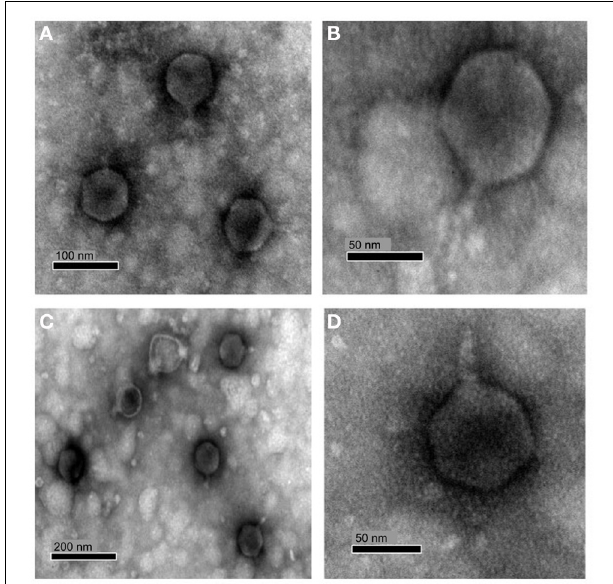
FIGURE 1 | TEM micrograph of RLP1 and RPP1 negatively stained with uranyl acetate. RLP1— (A,B) and RPP1— (C,D) . Based on their morphology phages were classified into the Podoviridae family. Magnification: (A) × 120,000, (B) × 300,000 (C) × 75,000 and (D) × 200,000.